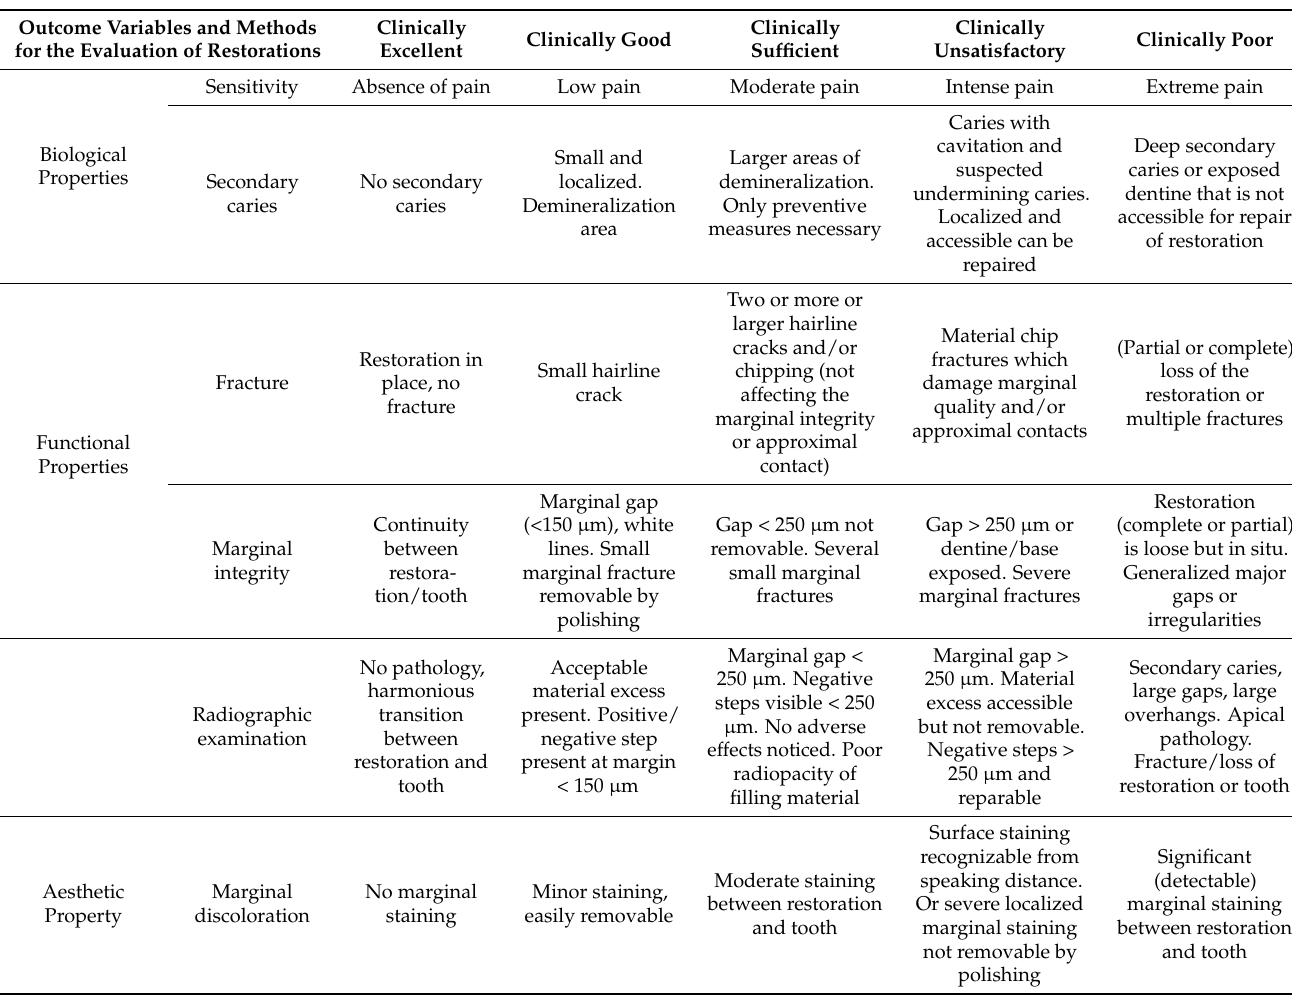
Table 2. Federation Dentaire Internationale (FDI) criteria used to assess the biological, functional, and aesthetic properties of